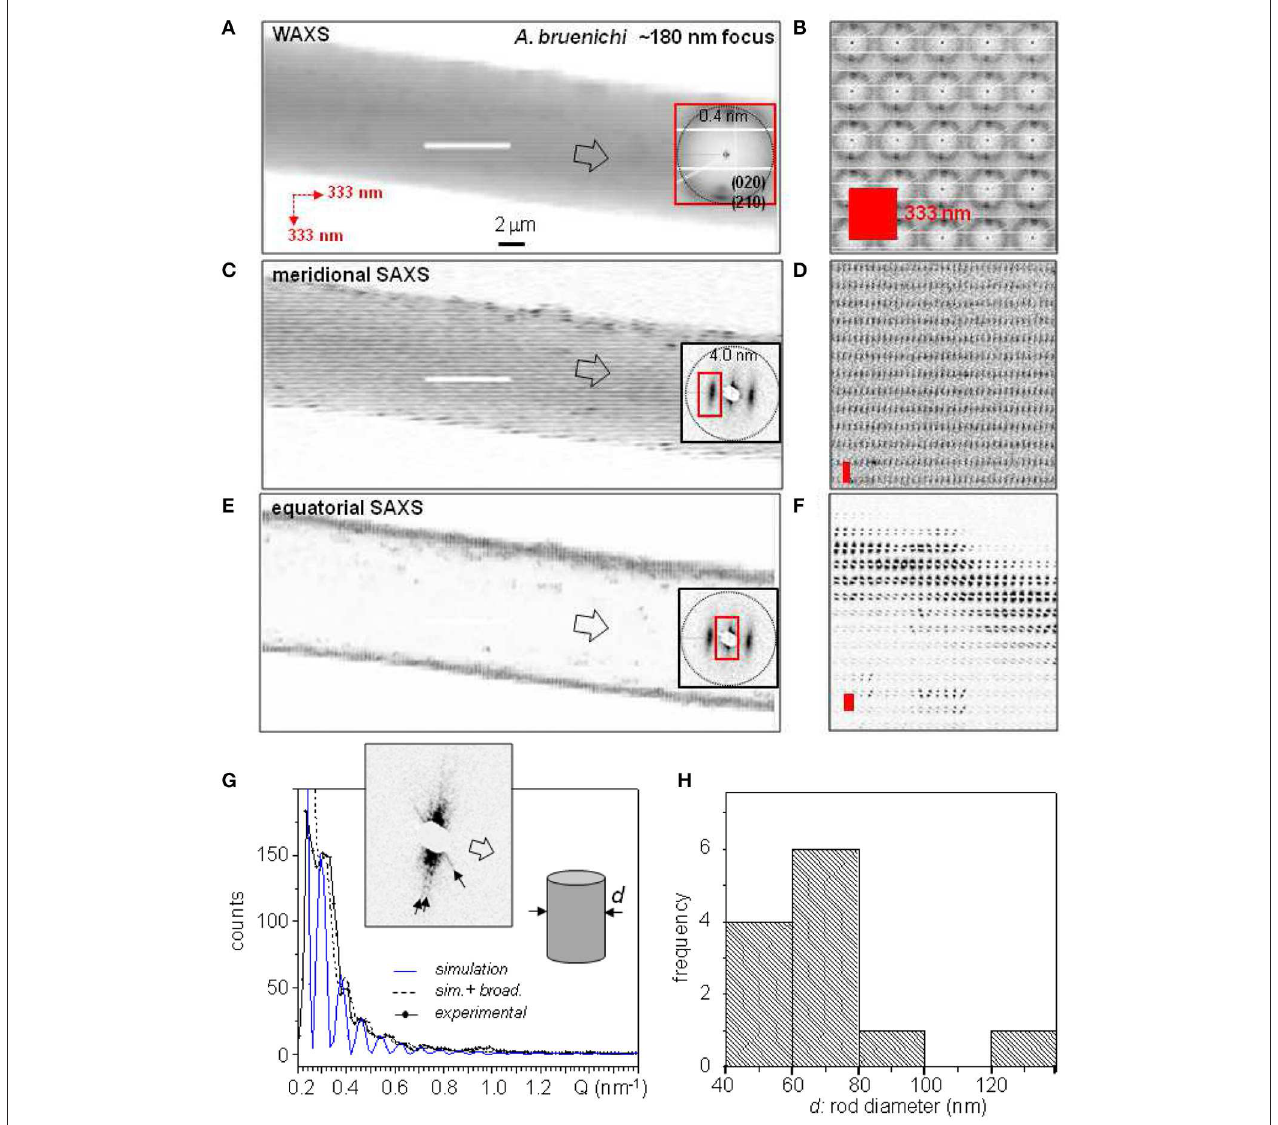
FIGURE 3 | Composite images of A. bruennichi’s bridge-thread based on 333 nm hor × 333 nm ver raster-steps through 170 nm hor × 170 nm ver (fwhm) focus. The insets show patterns from the center of the fiber. (A) Based on strongest WAXS peaks and SRO scattering. (C) Based on meridional SAXS correlation peak. (E) Based on equatorial SAXS streak. (B,D,F) Zooms of composite images to the left; red rectangles correspond to step-increments. (G) Simulation of scattering from nanofibrils in the skin-layer by cylindrical model. (H) Histogram of skin-layer cylinder diameters. Reproduced/adapted from Riekel et al. (2017) with permission from ACS.